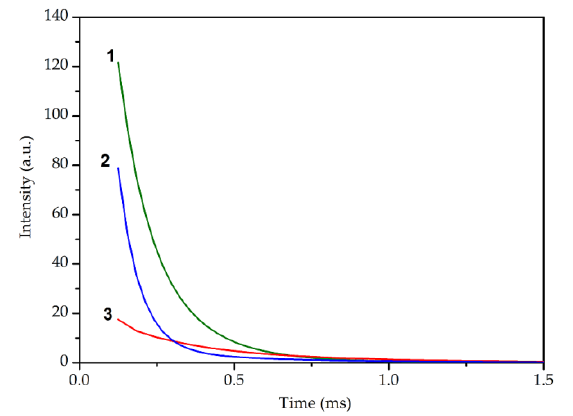
main energy transition intensities η = I( 5 D 4 − 7 F 5 )/I( 5 D 4 − 7 F 6 ) at the wavelengths of λ = 544 nm and λ = 489 nm.